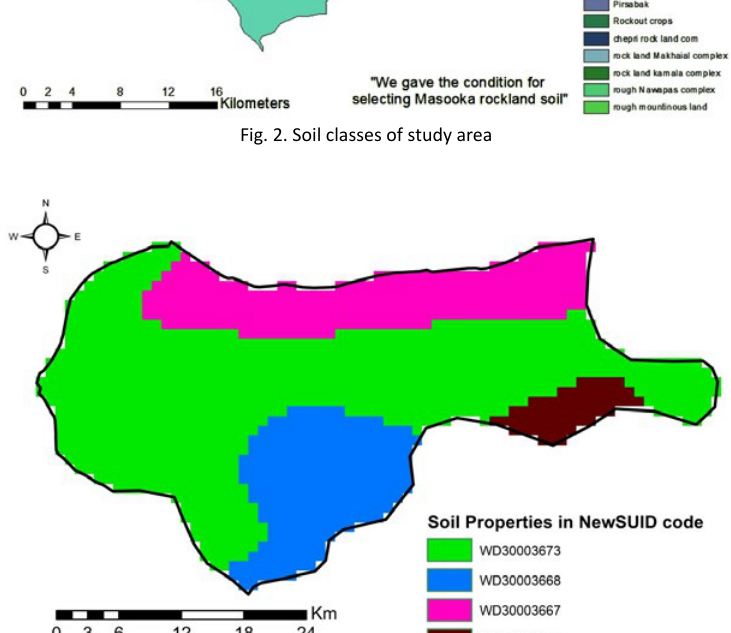
Fig. 3. Soil properties of study Fig. 3: Soil properties of study area